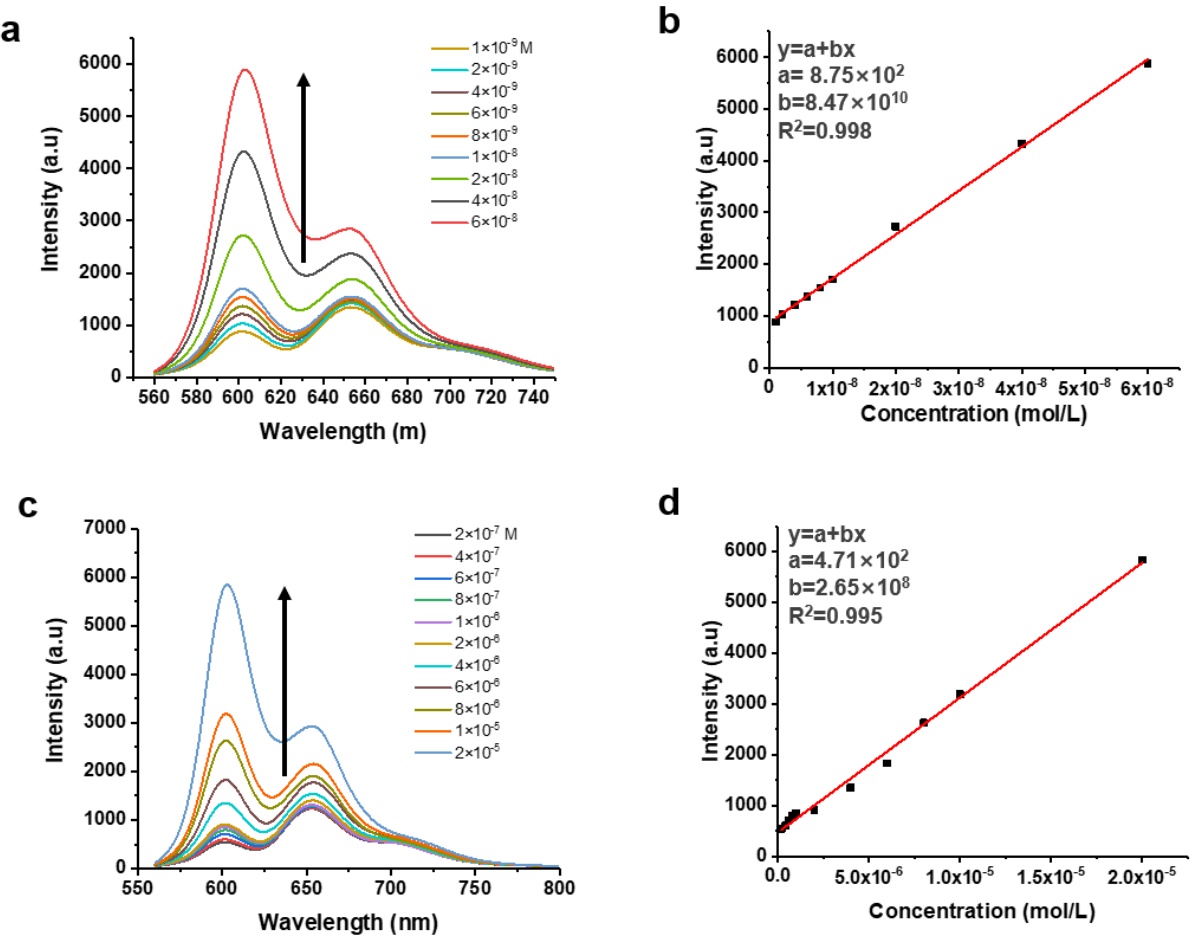
Figure 7. ( a ) Alternations of the PL spectral of C-dots (10 µ g/mL) in presence of pyridine solutions of different concentrations. ( b ) Calibration curve showing the linear relationship between the PL intensities of C-dots at 606 nm and the concentrations of pyridine. ( c ) Alternations of the PL spectral of C-dots (10 µ g/mL) in presence of lysine solutions of different concentrations. ( d ) Calibration curve showing the linear relationship between the PL intensities of C-dots at 606 nm and the concentrations of lysine. Table 3. Key parameters for the detection of NCOBs using PL-based, C-dots derived sensing assays NCOBs